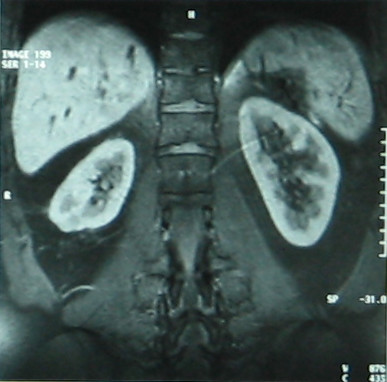
Postoperative MRI. Follow-up MRI at 9 months postoperatively showing normal remaining kidney with scar formation.